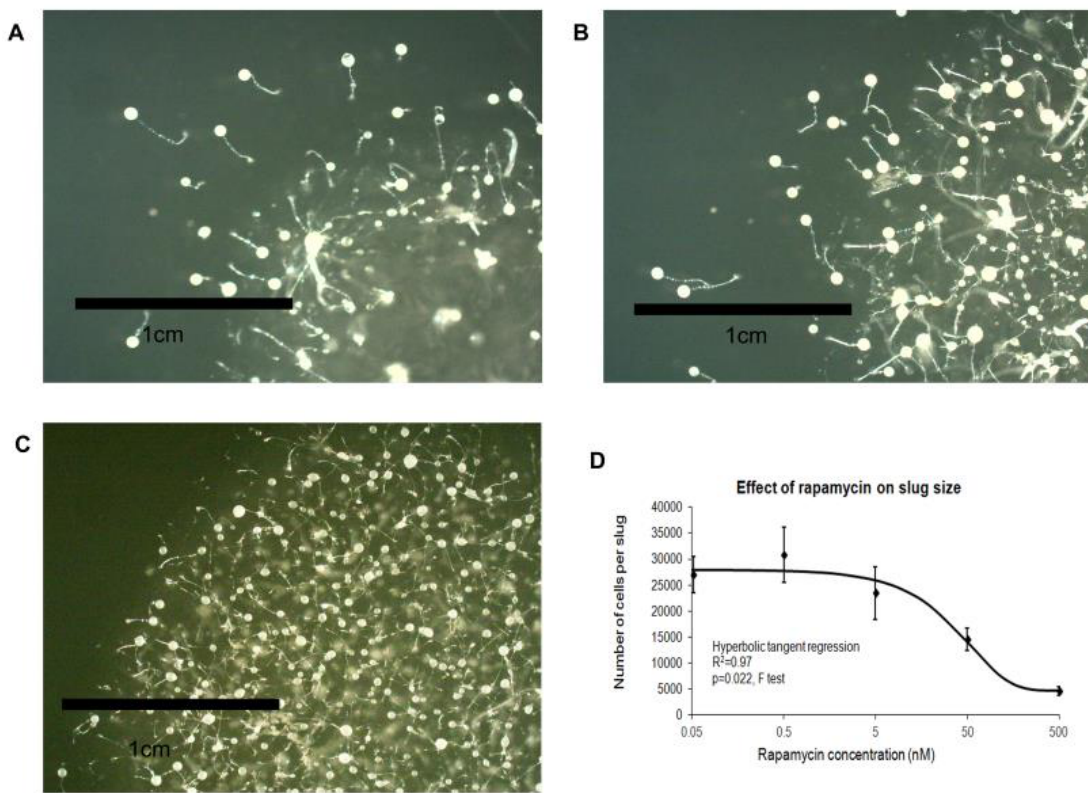
Figure 6. Prolonged rapamycin treatment affects development. Wild type AX2 cells were exposed to rapamycin at: 5 nM ( A ); 50 nM ( B ); and 500 nM ( C ). As the rapamycin concentration increased, the size of the fruiting bodies decreased. ( D ) The average cell counts from 30 slugs for each strain was plotted against the rapamycin concentration with error bars representing standard deviations. The cell counts decreased with increasing rapamycin concentration. The regression was significant at the indicated p value (F test). The line was fitted with the least squares method to a hyperbolic tangent function.